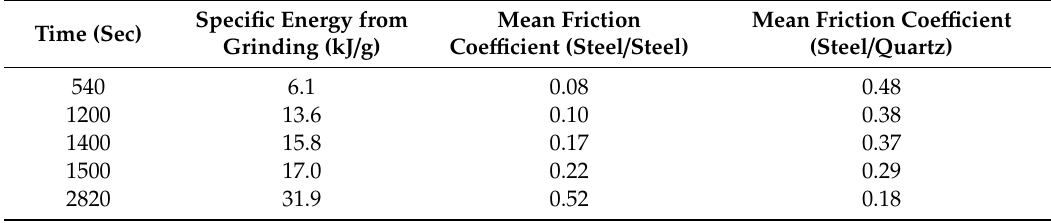
Table 2. Friction coe ffi cient values for quartz at di ff erent grinding times, with a fixed ratio between the grinding mass and material